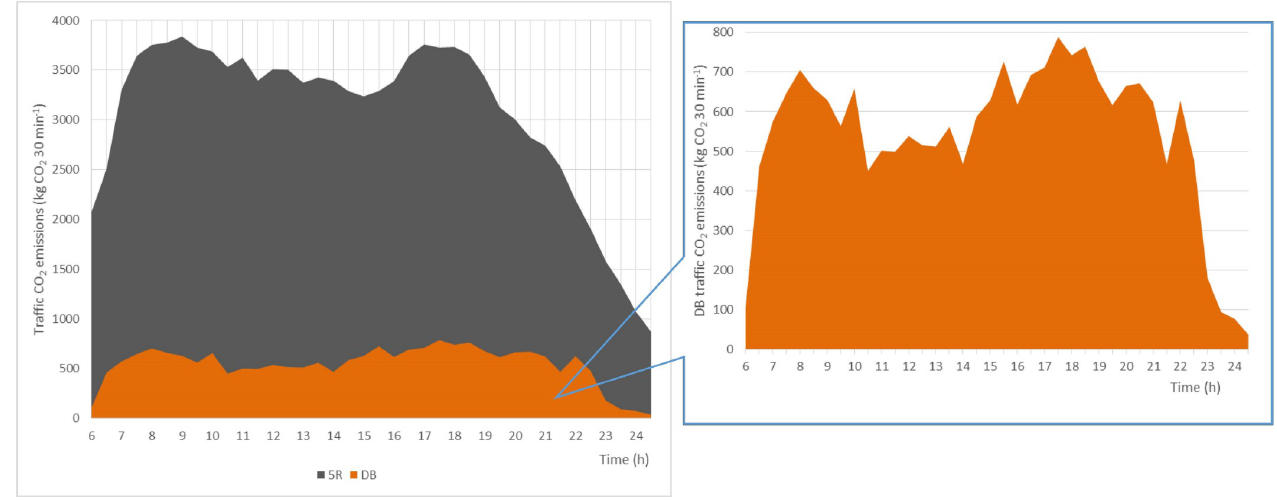
Fig 1. Comparison of diurnal variations of traffic CO 2 emissions at 5R and DB.